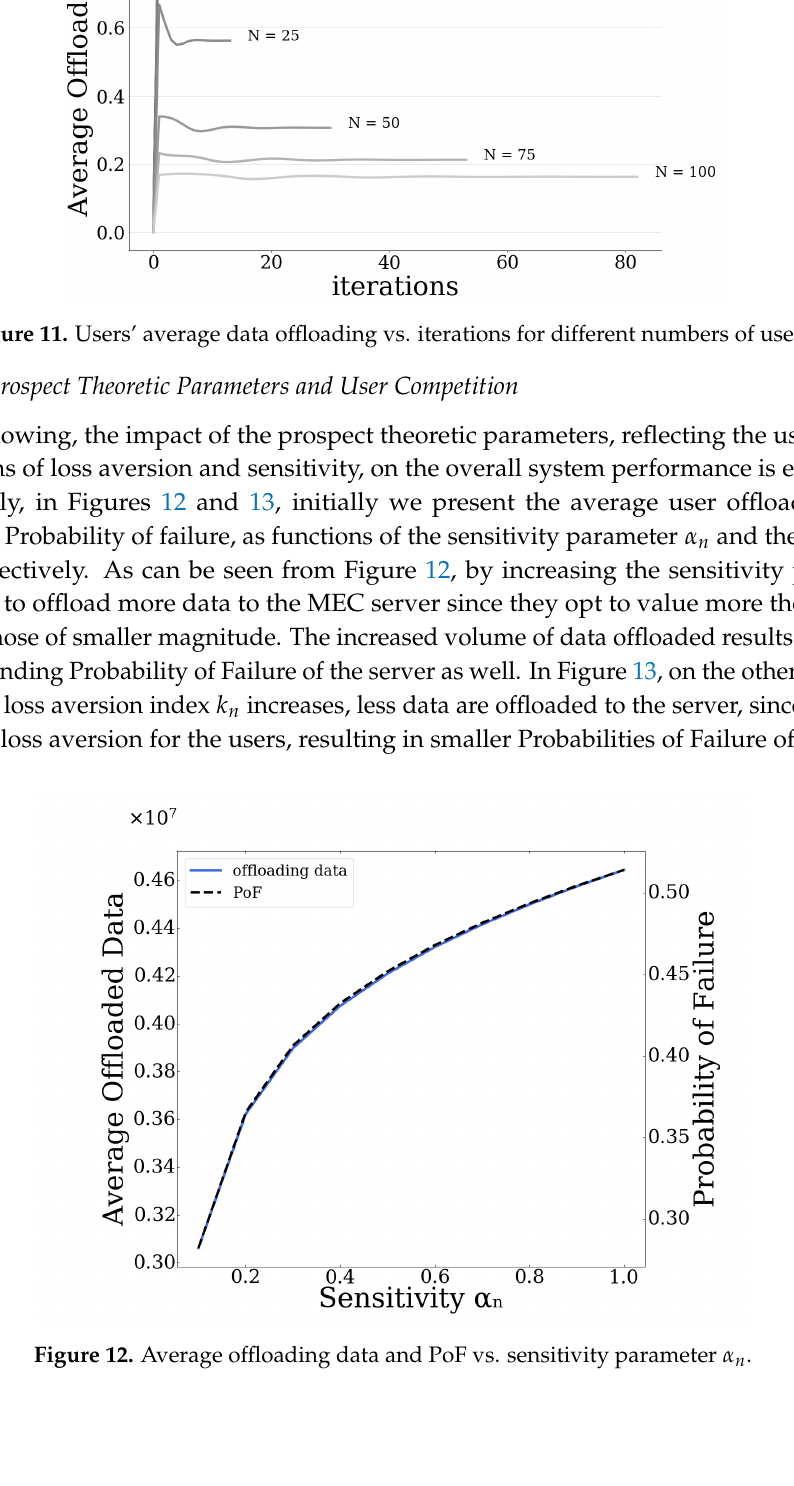
offloading data and PoF Figure 12. Average α n vs sensitivity parameter